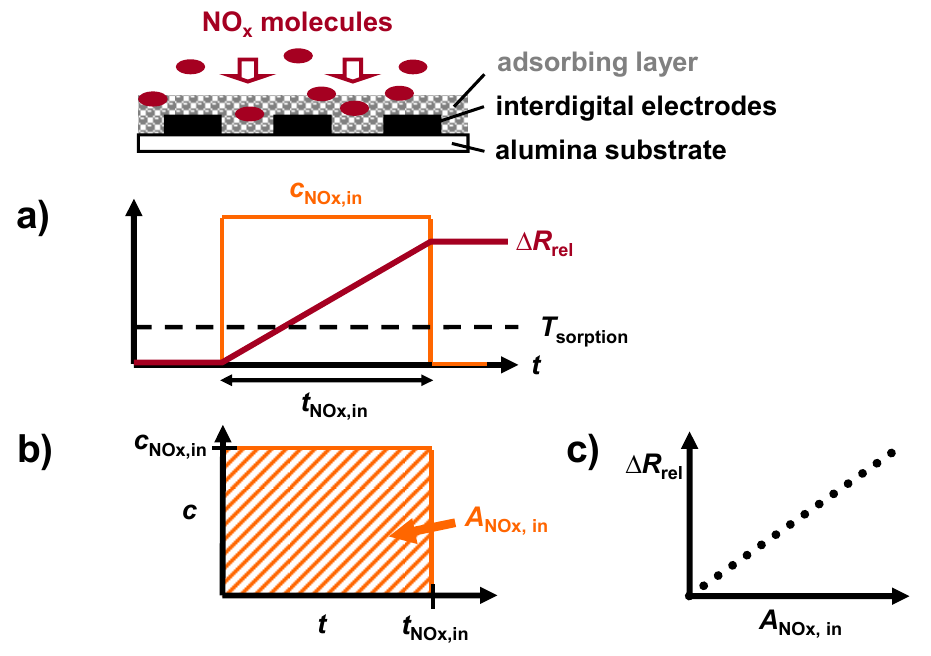
Figure 4. Data analysis during progressive NO sensor response ∆ R , ( c ) characteristic ∆ R A NOx,in